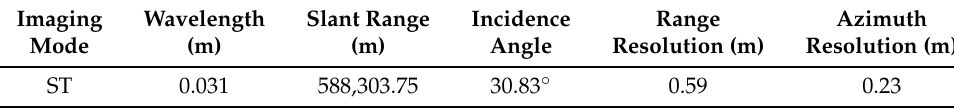
Figure 10. Display of the TerraSAR-X data. SAR image in the white box overlaid on Google Earth optical image. Range and azimuth direction are indicated by yellow arrows. The high-rise building marked by a red rectangle is investigated next. Table 1. System parameters of TerraSAR-X